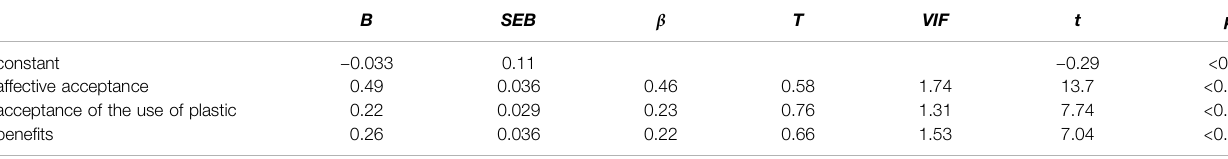
TABLE 2 | Step-wise multiple linear regression model for the cognitive acceptance of CCU insulation boards: Adjusted R 2 (cid:1) 0.57 ( N (cid:1)